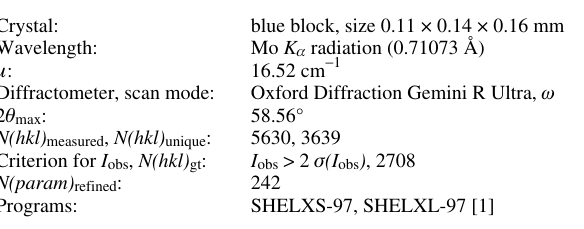
Table 1. Data collection and handling.